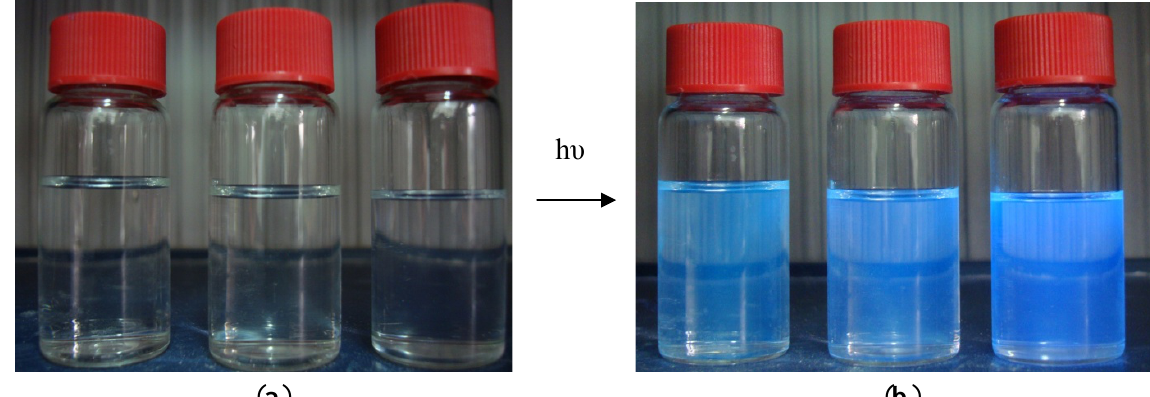
Figure 2. Photographs of solutions of 2 , from left to right in CH